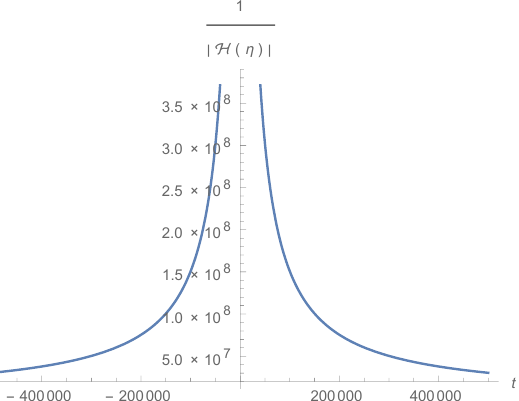
Figure 6. Time evolution of the comoving Hubble radius for the time-symmetric bouncing solution of Figure 2 in radiation